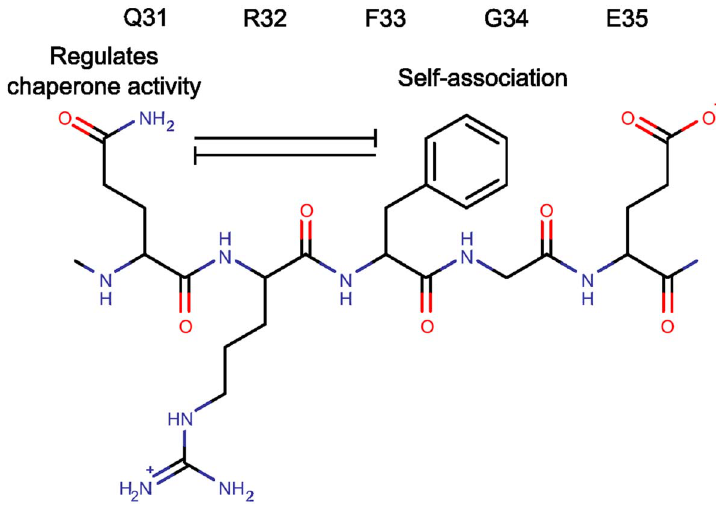
Figure 9. Cartoon summarizing the interplay between Q31 and F33 in defining the properties of HSPB6. (TIF) Figure S2 SDS-PAGE analysis of all HSPB6 constructs. Equal amounts of each purified protein were loaded on a 15% polyacrylamide gel alongside the PageRuler prestained protein